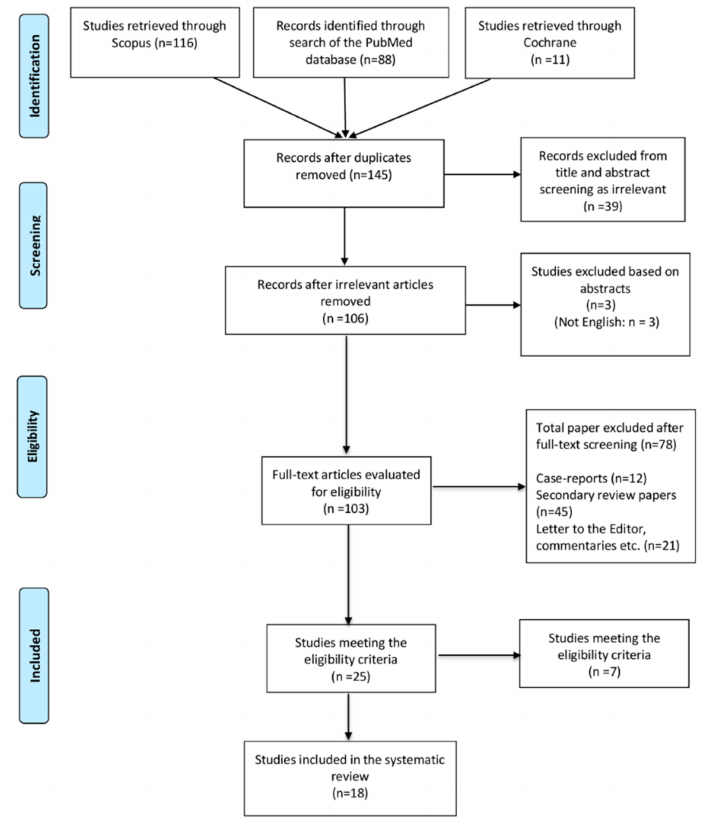
Figure 2. PRISMA flow